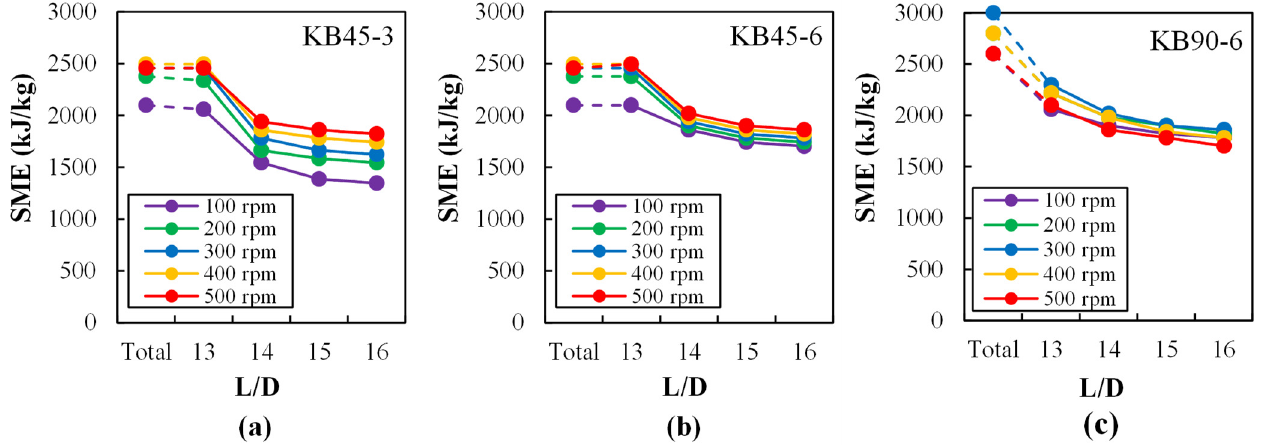
Figure 5. Specific mechanical energy SME (kJ/kg) at ports L/D = 13, 14, 15, and 16 along the mixing zone as a function of screw speed (50 to 500 rpm) for each kneading block: ( a ) KB45-3, ( b ) KB45-6, and ( c ) KB90-6. “Total” denotes SME values without any material sampling.